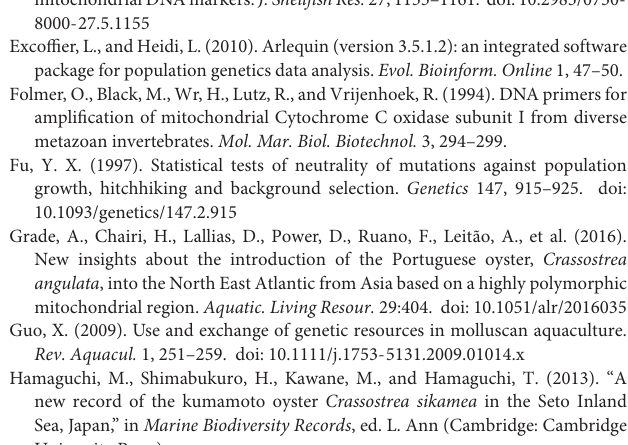
Supplementary Figure 1 | Nucleotide mismatch distribution analysis of Crassostrea angulata from XSB (A) and ZZ (B) as well as Crassostrea sikamea from XSB (C) , SMB (D) , YQB (E) , ZZ (F) , NT (G) , and JP (H) , the ordinate represents frequency of differences in the corresponding populations. Supplementary Figure 2 | (A) The sequence alignment of the ITS1 of Crassostrea sikamea and Crassostrea angulata , of which the serial number and accession number in the NCBI database were included, Hind III restriction sites were highlighted. (B) The forward primer (MNR-F) and (C) reverse primer (MNR-S-R) alignment of the specific MNR of Crassostrea sikamea and other six Crassostrea oysters, of which the serial number and accession number in the NCBI database were included, primers sequences were